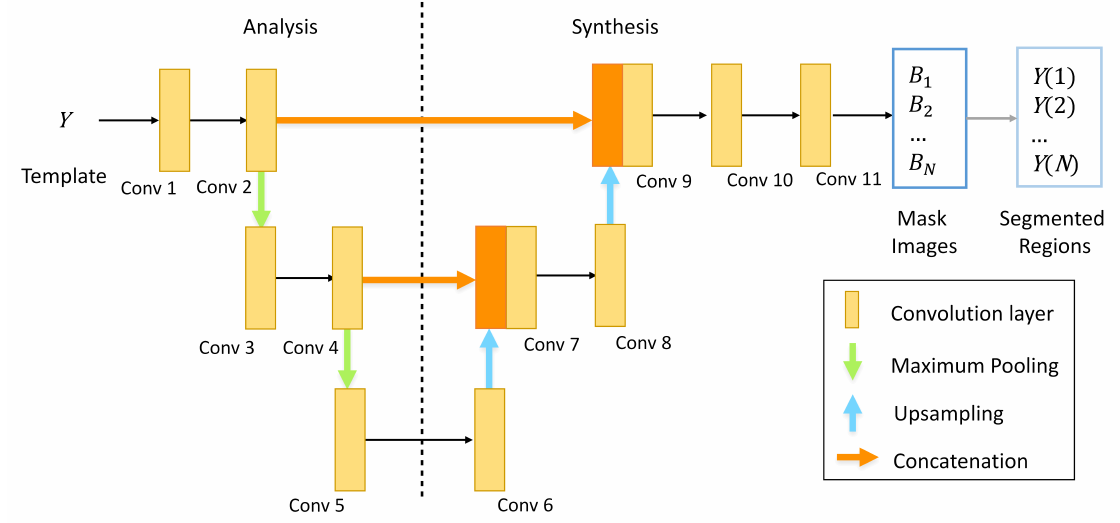
Figure 5. An example of the FCN for the proposed algorithm. The FCN in this example contains 11 convolution layers, which are denoted by Conv i , i =